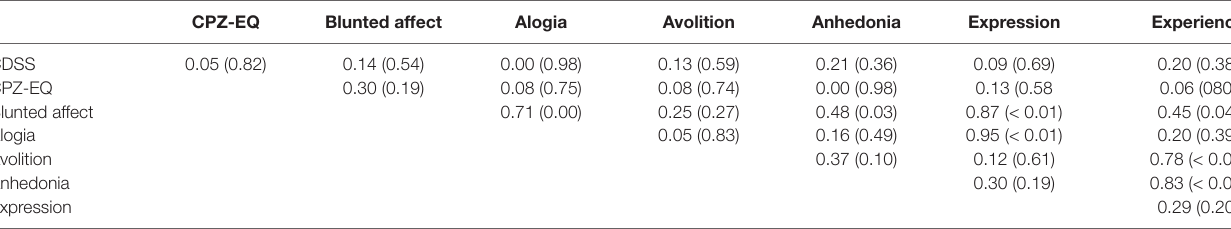
TABLE 2 | Correlations Between Variables at Pretest-Spearman rho (2-sided